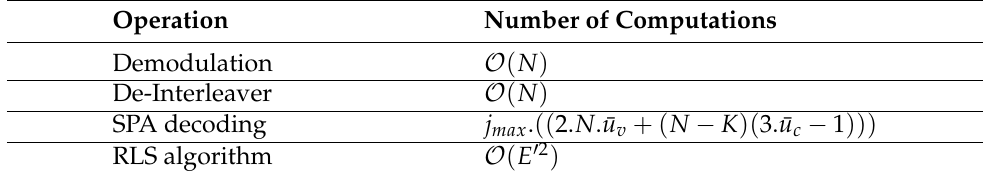
Table 4. Summary of the number of computations.